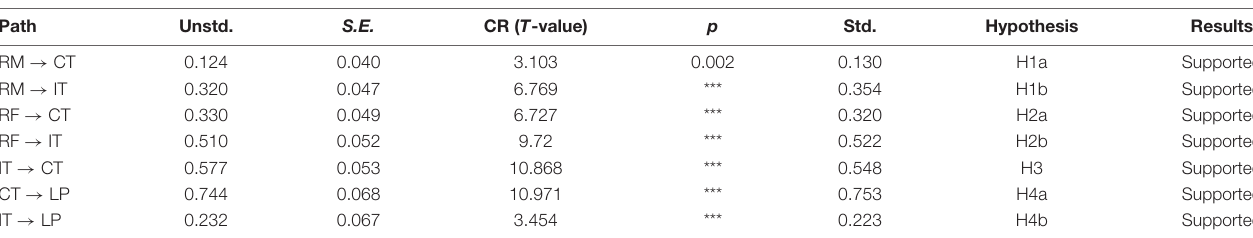
TABLE 4 | Fitting path